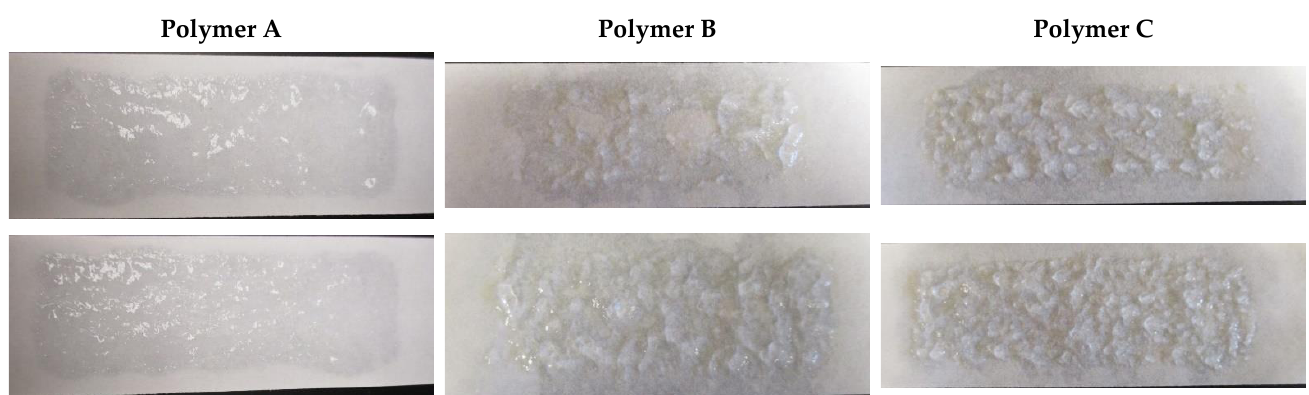
Figure 5. Peel strength comparison between hyaluronic acid gels.